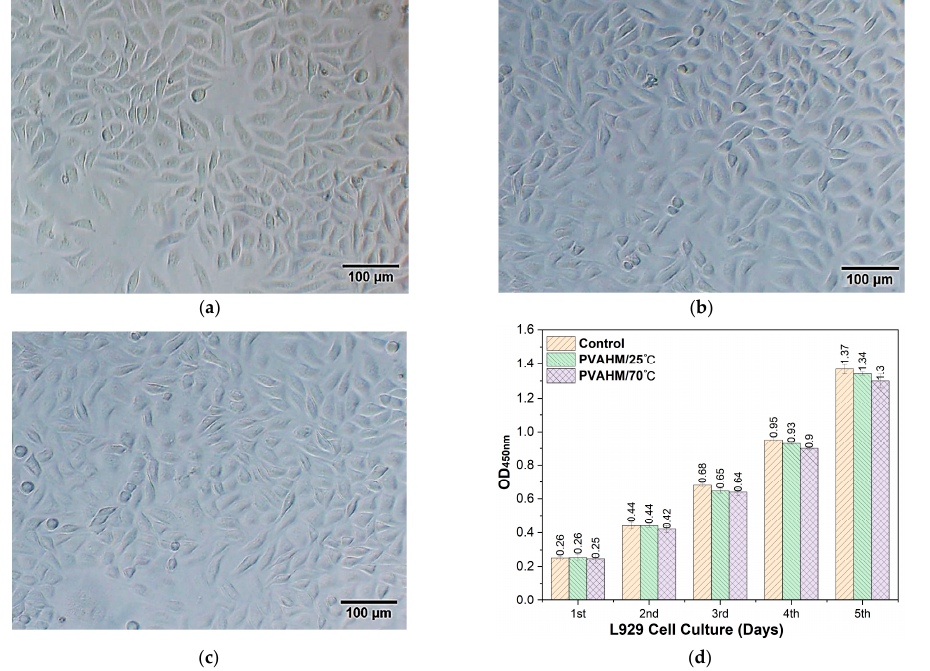
Figure 5. Adherence, colonization, and growth of murine L929 cells on two PVAHMs on the 5th day: ( a ) control; ( b ) PVAHM/25 °C; ( c ) PVAHM/70 °C; ( d ) cells status and growth diagram of L929 cells on PVAHM for 1~5 days ( n = 3).